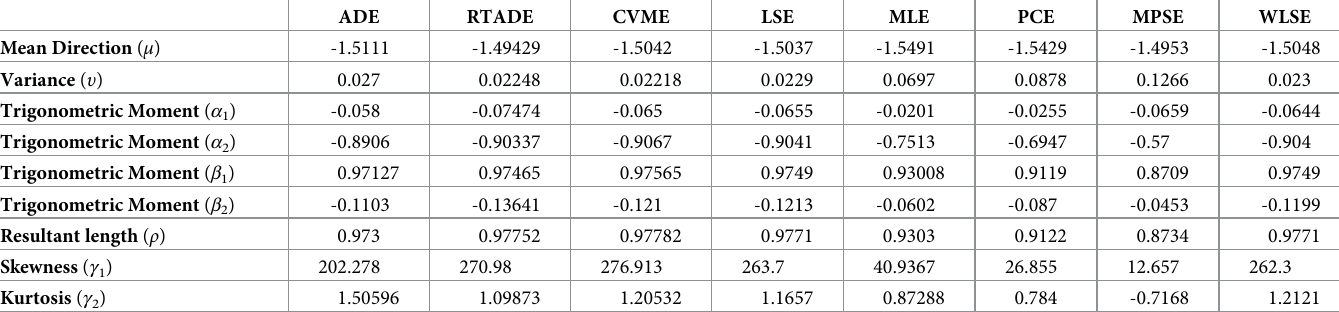
Table 5. Descriptive statistics for different parameters estimates methods.